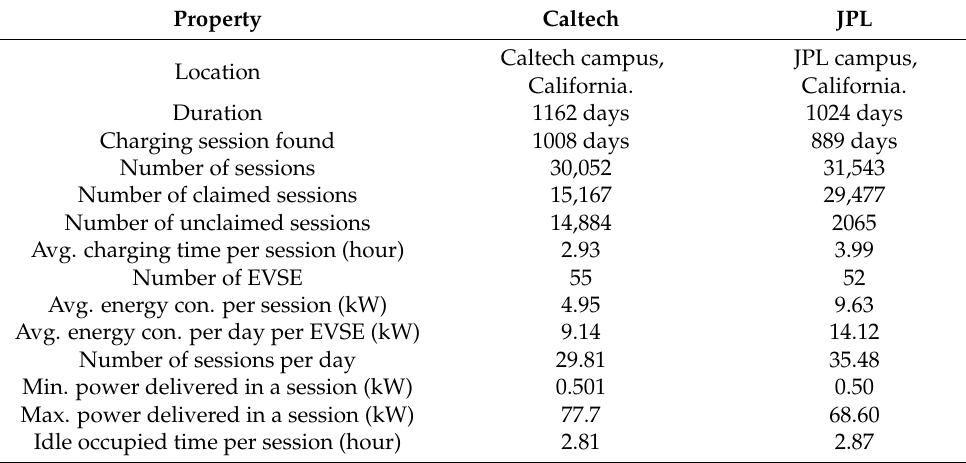
Table 1. Basic information of the charging